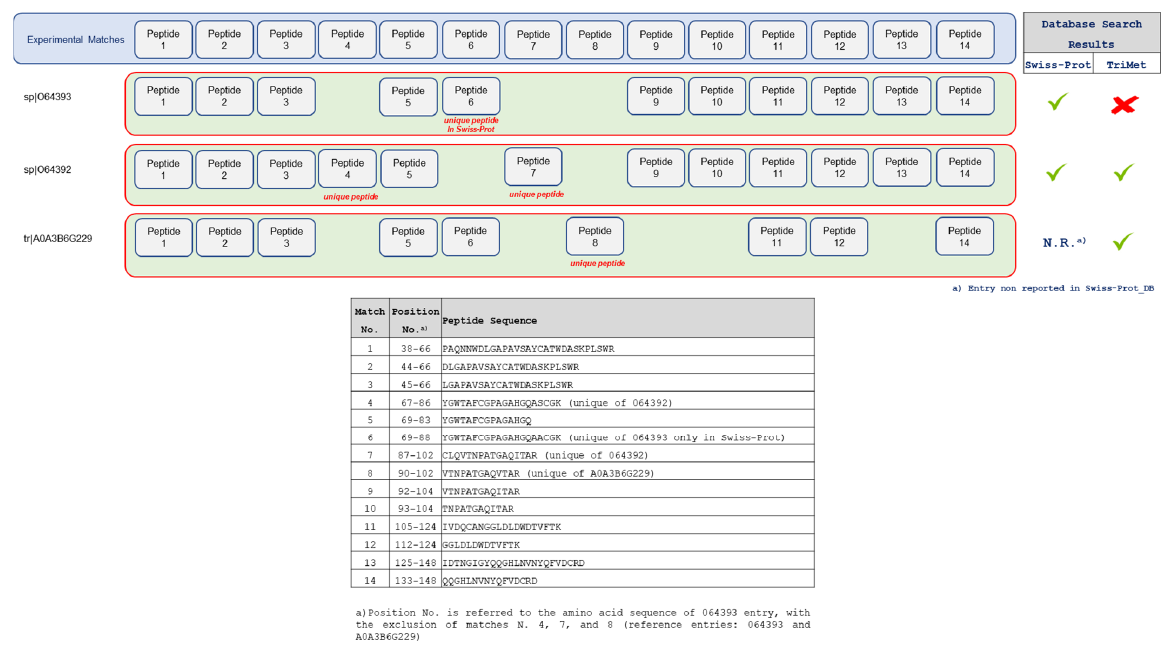
Figure 6. Occam’s razor strategy applied to assemble the fourteen analyzed peptide sequences